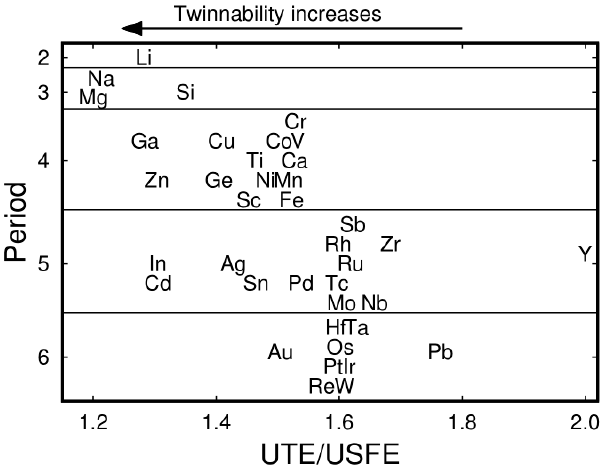
Figure 6. Unstable twinning energy (UTE) to unstable stacking fault energy (USFE) ratio for analyzed aluminum alloys. The positionof the analyzed alloy indicates the UTE/USFE value.